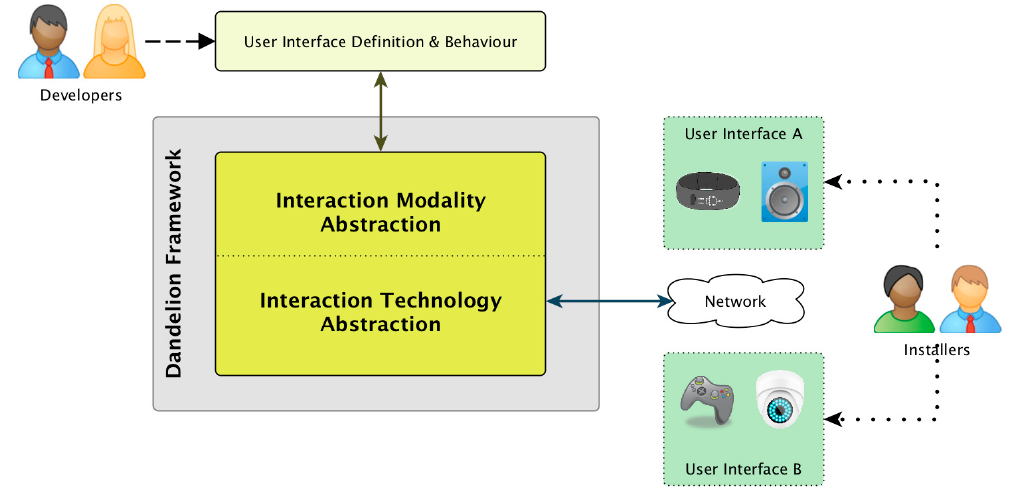
Figure 1. Overview of the Dandelion distributed architecture.